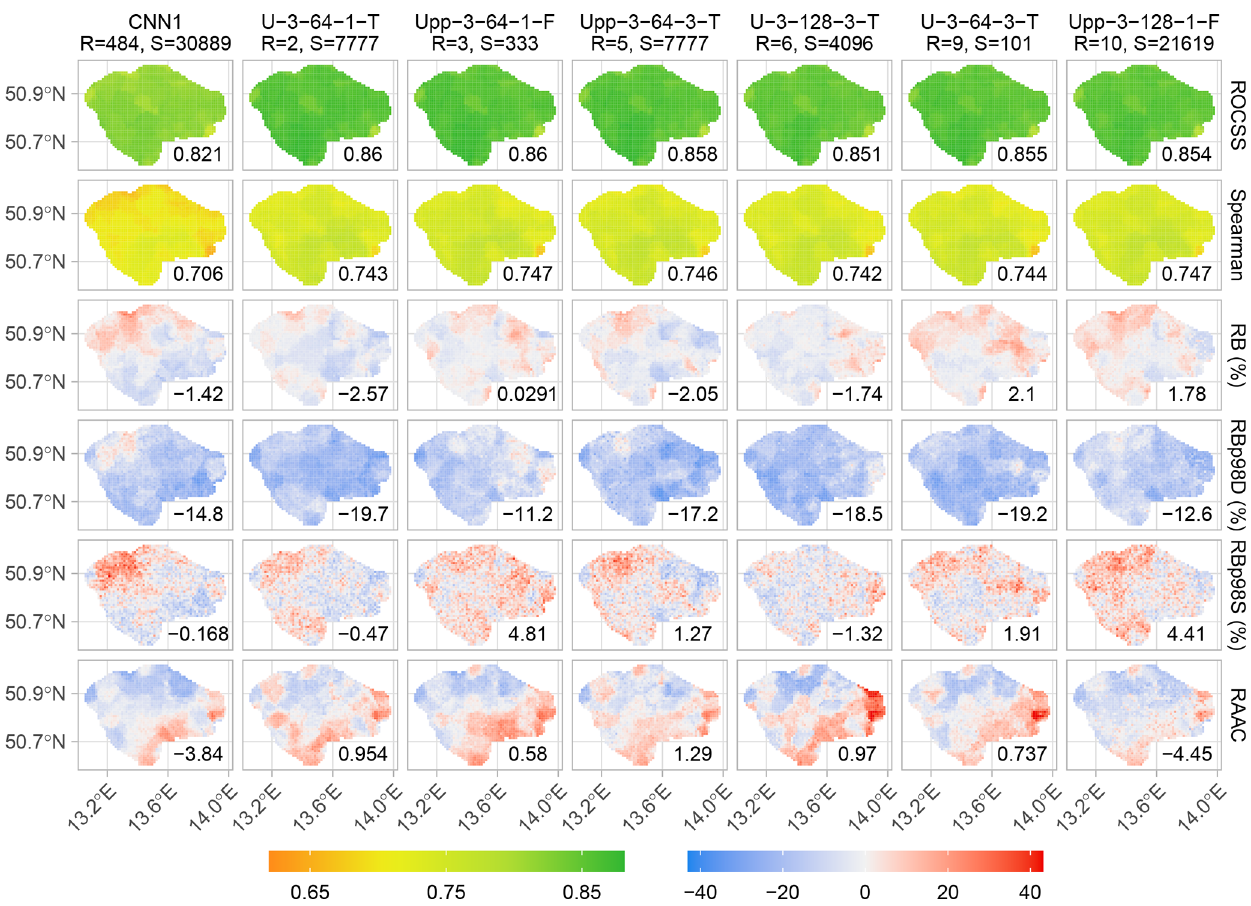
Figure 4. Spatially distributed validation metrics, row-wise, of CNN1 (benchmark) and a sub-selection of the best performing models. The numbers inside the panels represent the overall median of the metrics amongst the Eastern Ore Mountains domain. Note the shared scales among the